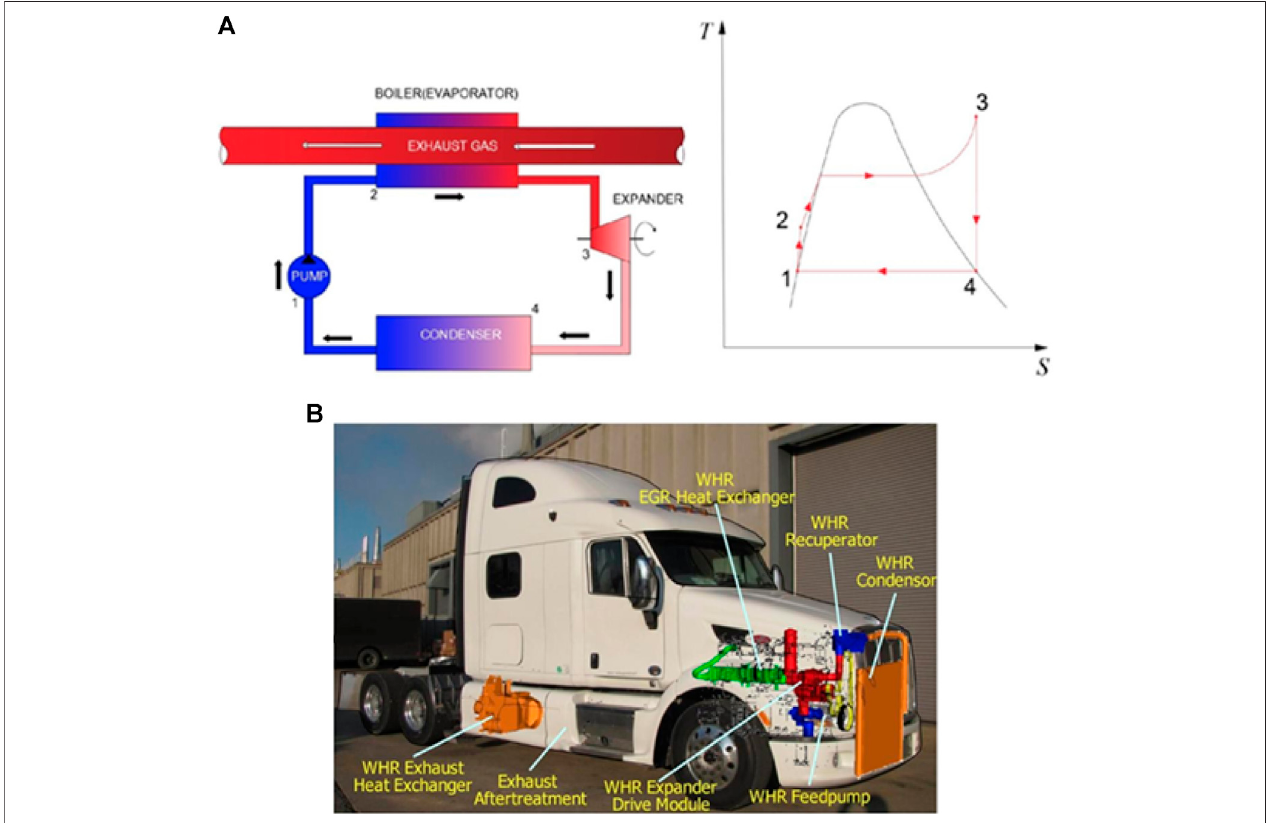
FIGURE 1 | ( A , top ) Rankine cycle system layout and T-s cycle diagram and ( B , bottom) installation of the waste heat recovery (WHR) system in a Class 8 tractor.